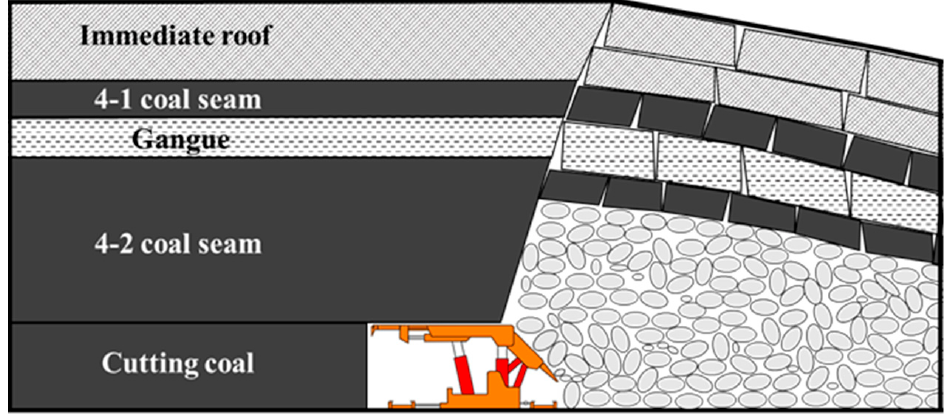
Figure 4. Schematic diagram of the location of top coal gangue in working face 42,018.